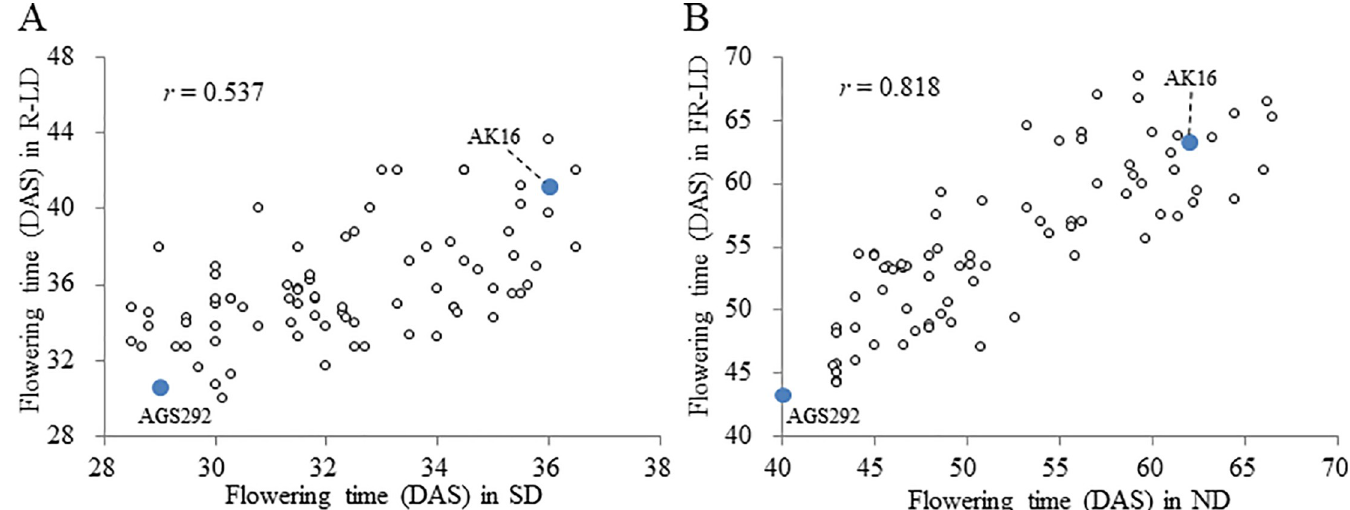
Fig 3. Scatter diagrams of flowering times in the F 6 progeny of a cross between AGS292 and AK16 (A) between SD and R-LD conditions and (B) between ND and FR-LD conditions.